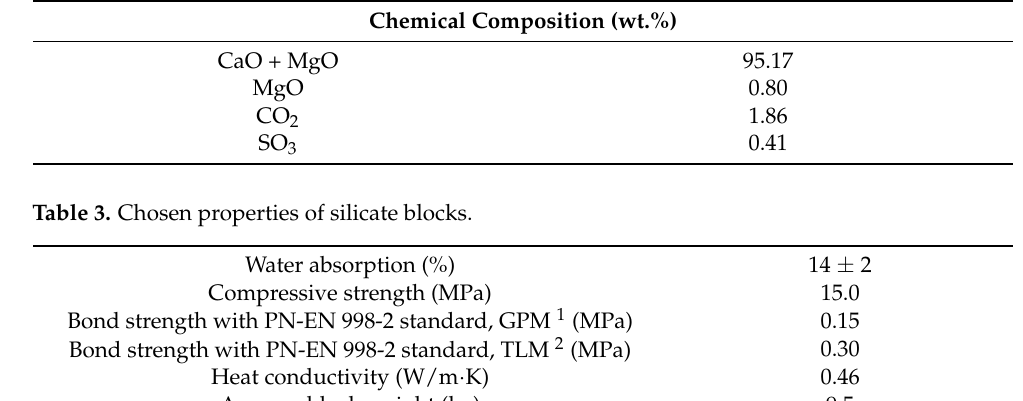
Table 2. Chemical composition of hydrated lime.